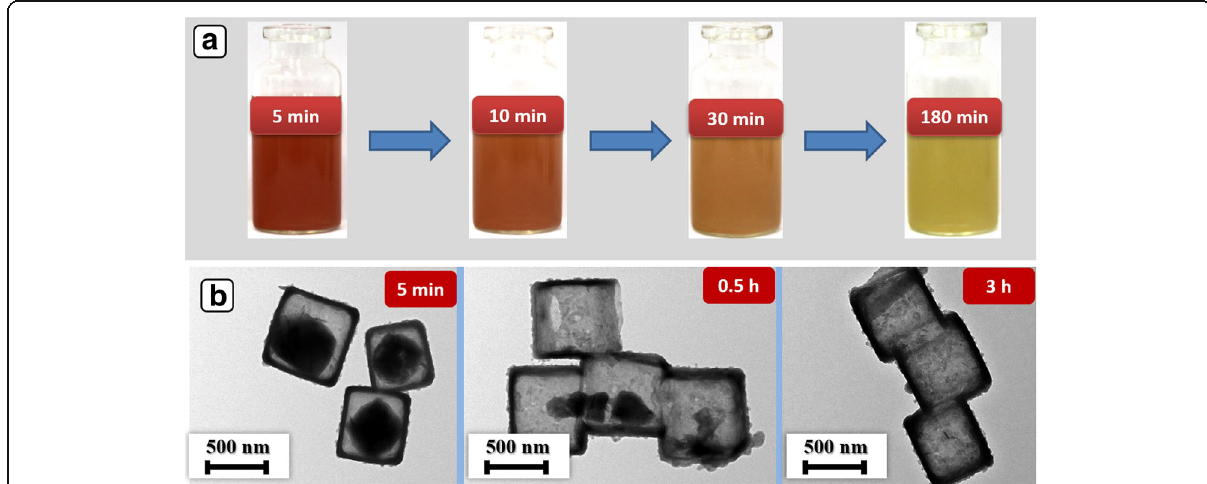
Fig. 3 a The optical photographs of the reaction system at a different reaction time. b TEM images of the products obtained at different reaction